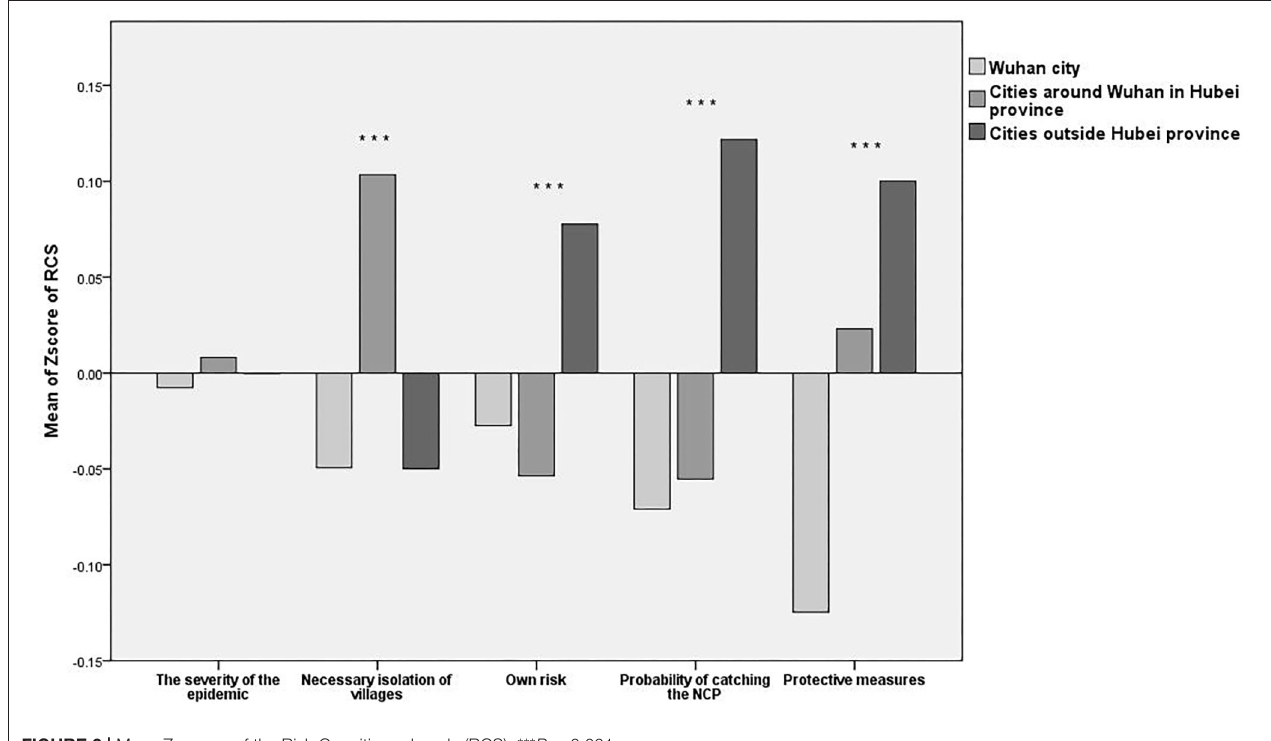
FIGURE 2 | Mean Z-scores of the Risk Cognitive subscale (RCS). *** P < 0.001.